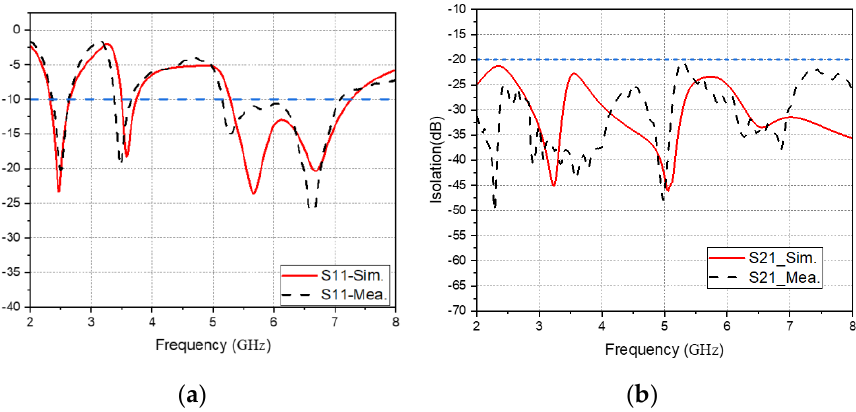
Figure 15. ( a ) Simulation and measurement of the reflection coefficient |S11| of Ant. 1, ( b ) Simula- tion and measurement of the isolation of Ant. 1 and Ant.